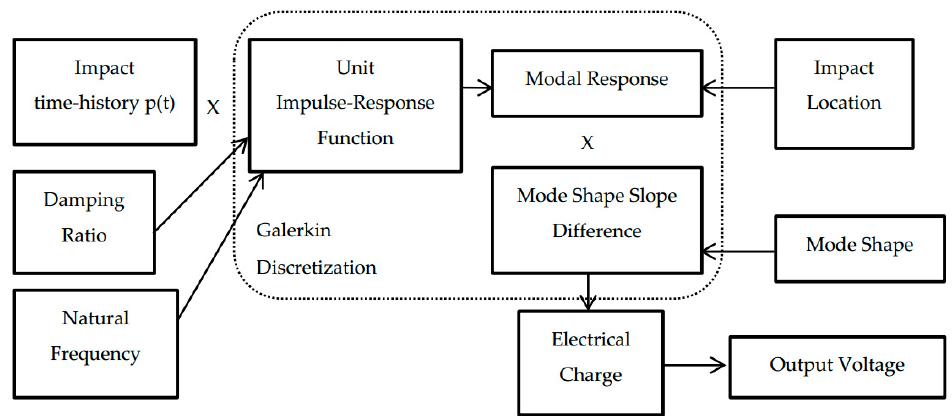
Figure 3. Flow of numerical simulation. Sensors 2016 , 16 , 601